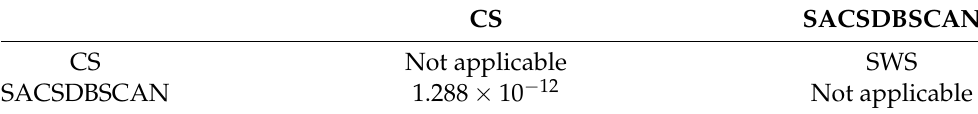
Table 15. p -values for instance d.5.